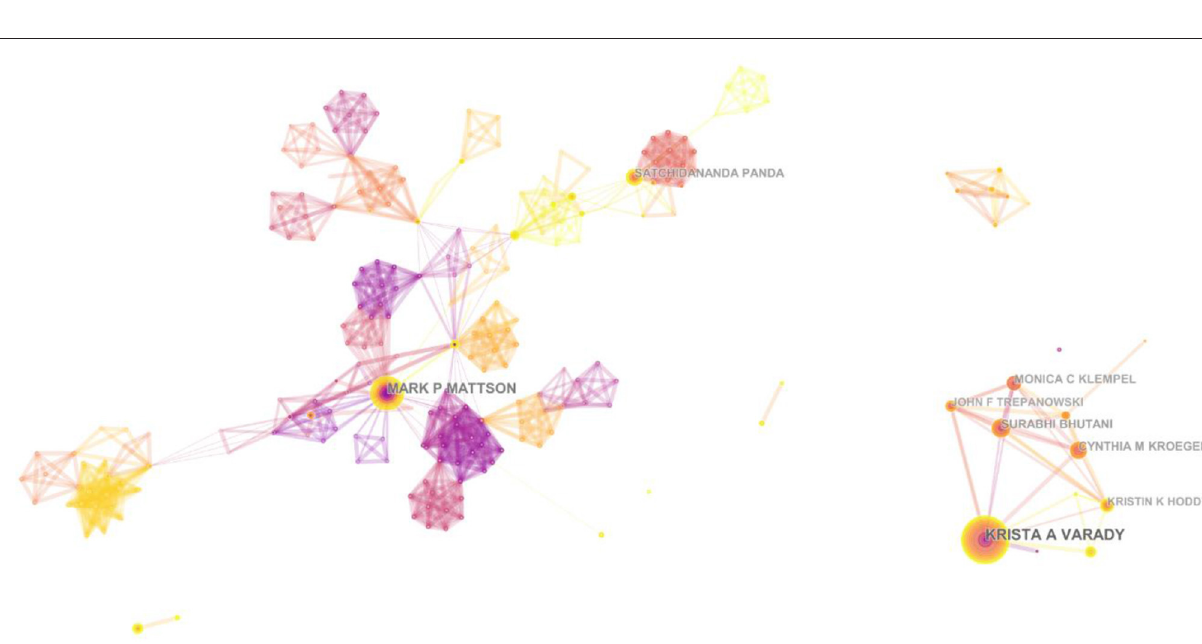
Frontiers in Public Health | www.frontiersin.org 7 July 2022 | Volume 10 | Article